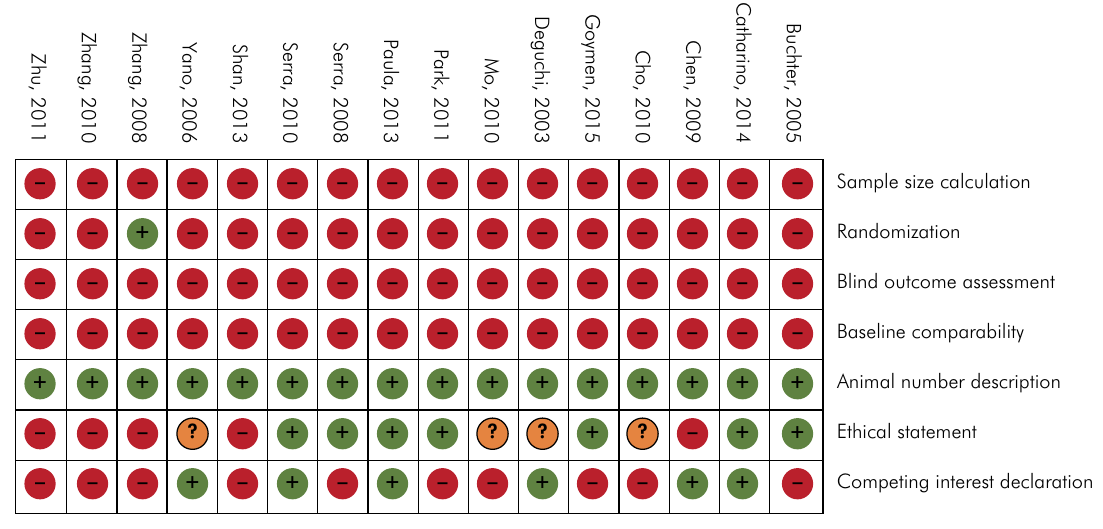
Figure 3. Risk of bias summary review of authors’ judgements about each risk of bias item for each included